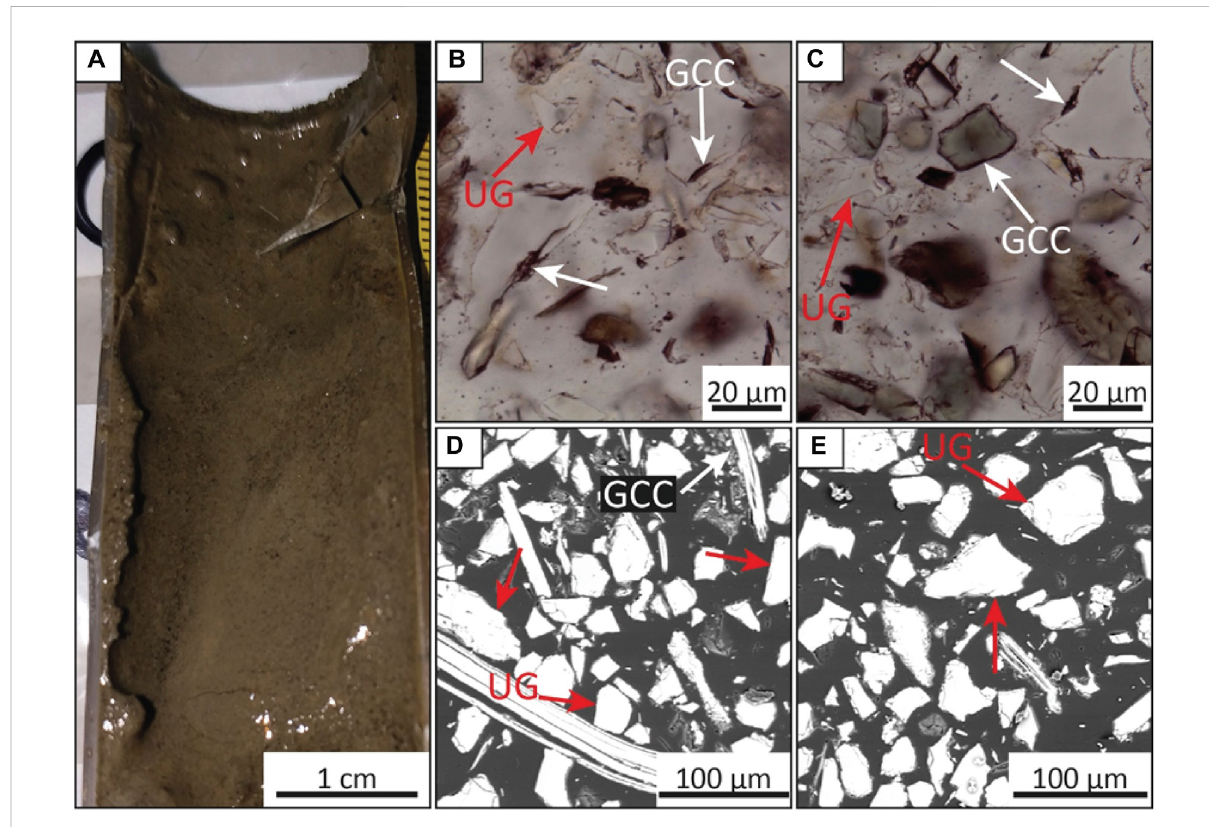
FIGURE 3 Images of samples from Station 036. (A) Syringe core image of the distal submarine lobe from Station 036. (B,C) Thin-section photomicrographs showing uncoated grains (UG; red arrows) and discontinuous grain-coating chlorite (GCC; white arrows) in Sample 4. (D) BSE image showing uncoated detrital grains and grain-coating chlorite (GCC) in Sample 4. (E) BSE image showing an uncoated grain (UG) and discontinuous, detrital grain-coating chlorite in Sample 4. (BSE, Backscattered